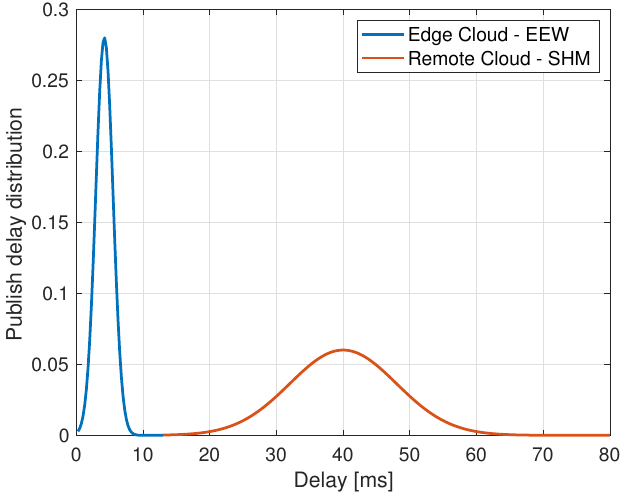
Figure 7. Distribution of delays at edge and remote cloud measured at the application layer.